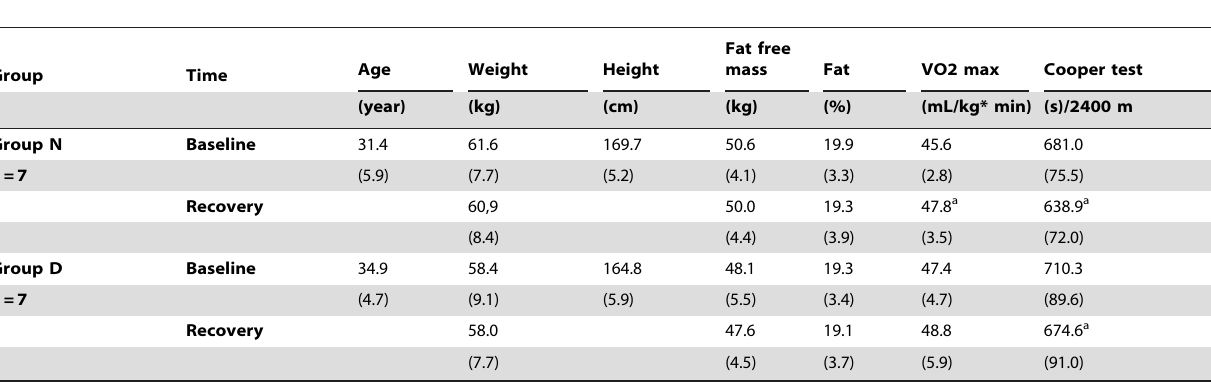
Table 1. Mean ( 6 SD) baseline and recovery characteristics of 14 female runners: group N=baseline serum ferritin (SF) . 20 m g/L, group D= baseline SF # 20 m